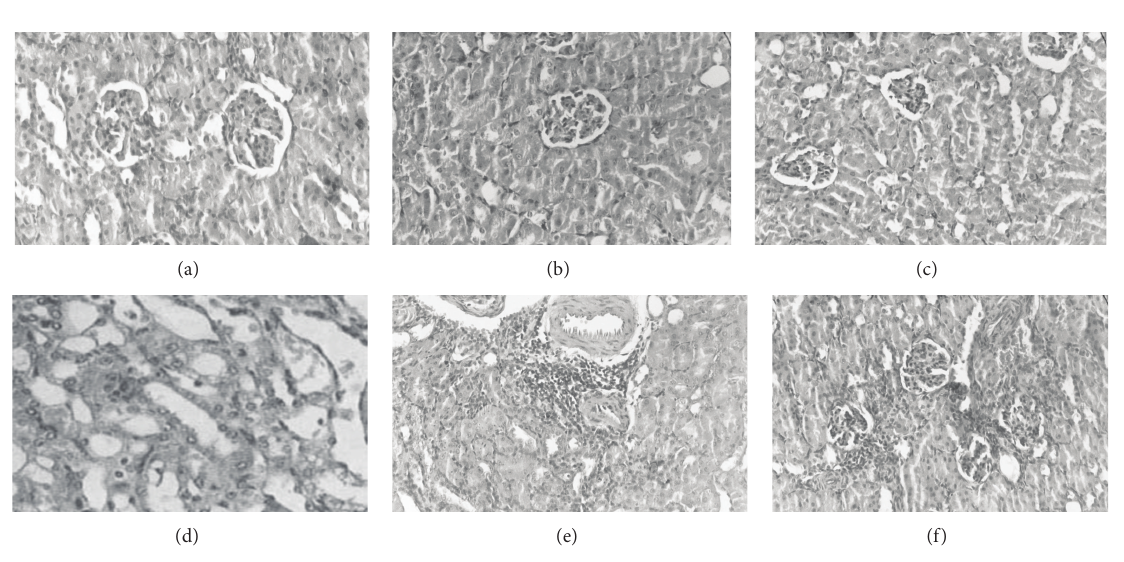
Figure 1: Effect of Physalis peruviana extract on the histology of kidney tissues in normal and cisplatin induced ARI rats. (a) Normal control; (b) 100mg physalis peruviana extract/Kg BW; (c) 150mg physalis peruviana extract/Kg BW; (d) cisplatin treatment alone; (e) pretreatment with 100 mg physalis peruviana extract/Kg BW+ cisplatin; (f), pretreatment with 150 mg physalis peruviana extract +